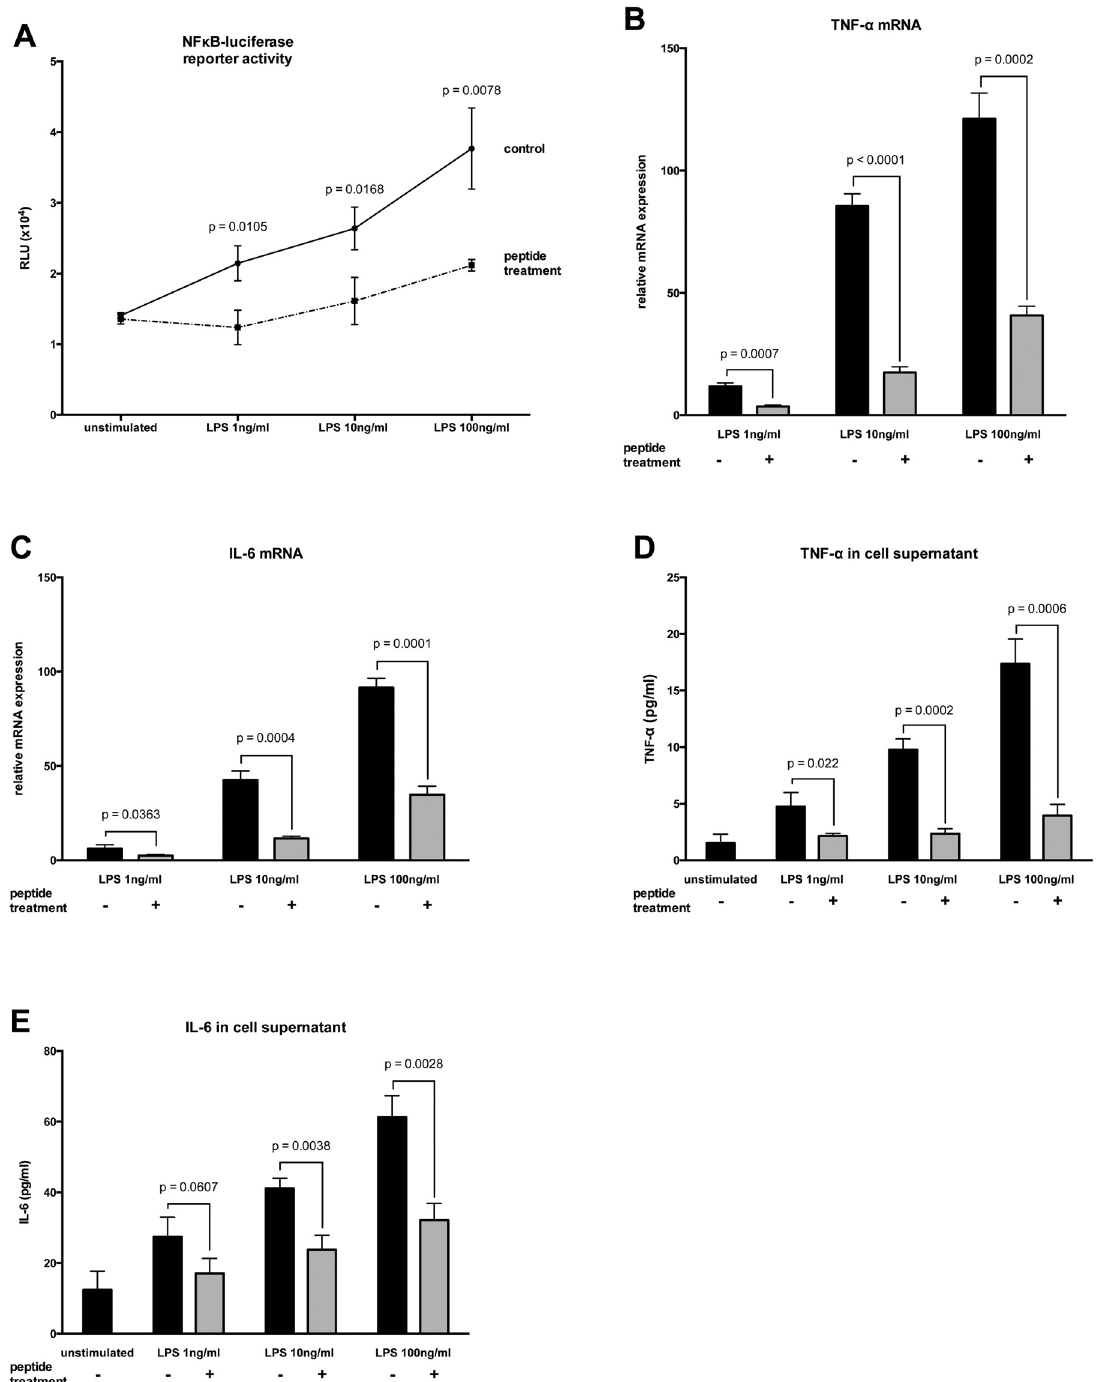
Fig 1. Inflammatory responses in HL-1 cells stimulated with LPS. (A) The cells were stimulated for 4 h with different concentrations of lipopolysaccharide (LPS) and treated with peptide 19 – 2.5 (20 μ g/ml; dashed line) or 0.9% NaCl (control; solid line). The data are expressed as the ratio of firefly to Renilla luciferase activity in relative light units (RLU). (B and C) Following a 4-h stimulation, the induction of mRNAs encoding the pro-inflammatory TNF- α (B) and IL- 6 (C) cytokines was monitored by RT-PCR. The inductions shown are normalized to non-stimulated cells. (D and E) Secreted protein concentrations of TNF- α (D) and IL-6 (E) were determined in supernatants using ELISA. Data represent the mean ± SD of triplicate samples, representative of three independent experiments. P values represent statistically significance between untreated (control) and treated cells with peptide 19 – 2.5 (peptide treatment) using multiple t-test with Holm- Š ídák